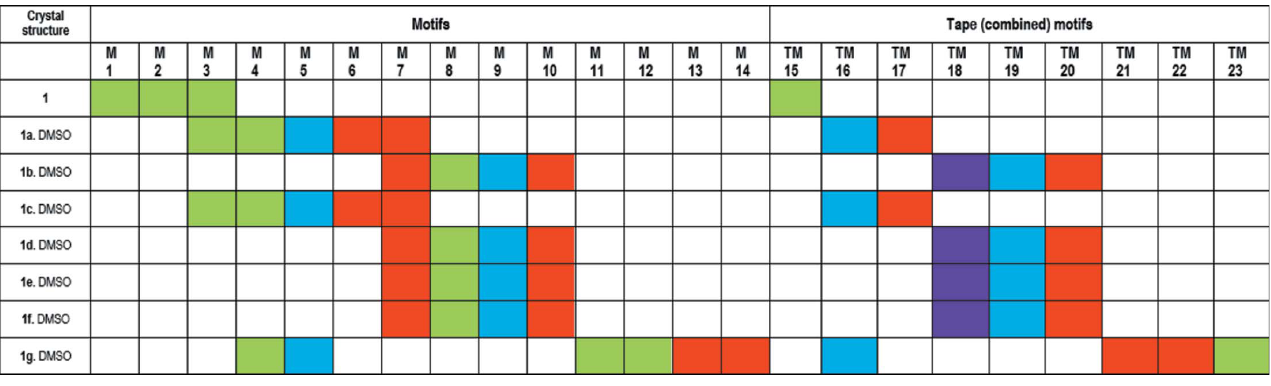
Figure 22 Summary of hydrogen-bond motifs found in this study. Green represents 1 – 1 interactions, blue represents 1 –solvent interactions, red represents 1 – coformer interactions and purple represents solvent– 1 –coformer